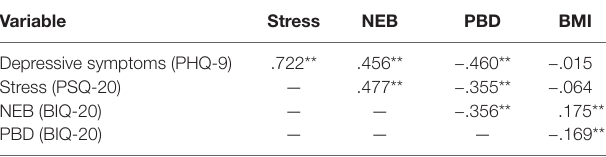
TaBle 2 | Spearman rho ( r s ) correlations of investigated